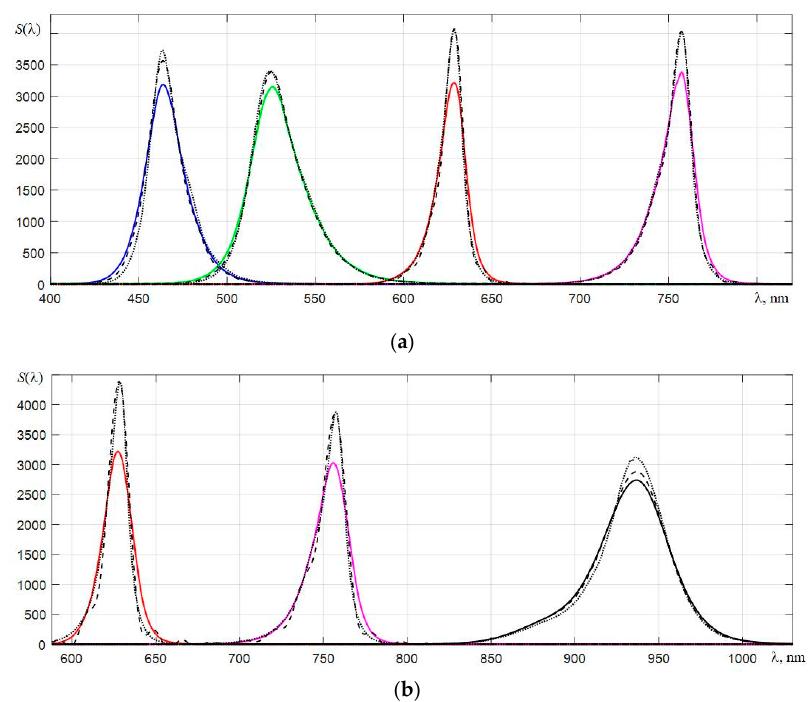
Figure 13. Spectra of LEDs S m ( λ ) registered by spectrometers C12880MA (a) and C11708MA (b) (solid lines), similarly normalized spectra S n ( λ ) obtained by AvaSpec 2048L (dotted lines), and the results of the correction of the spectra S m ( λ ) by Wiener filtering (dashed lines).